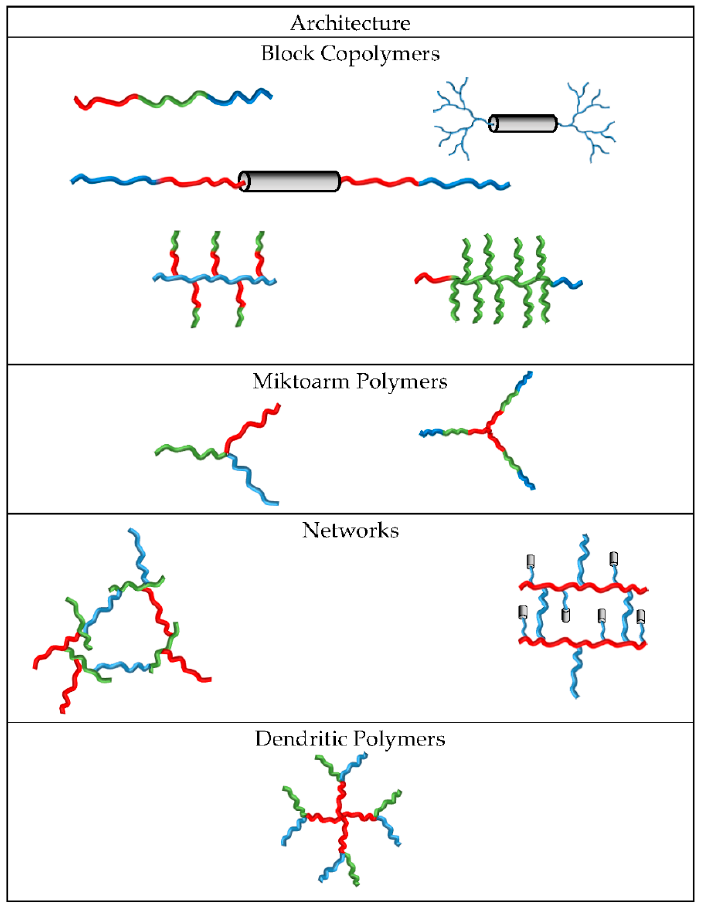
Figure 3. Examples for triphilic polymer architectures.